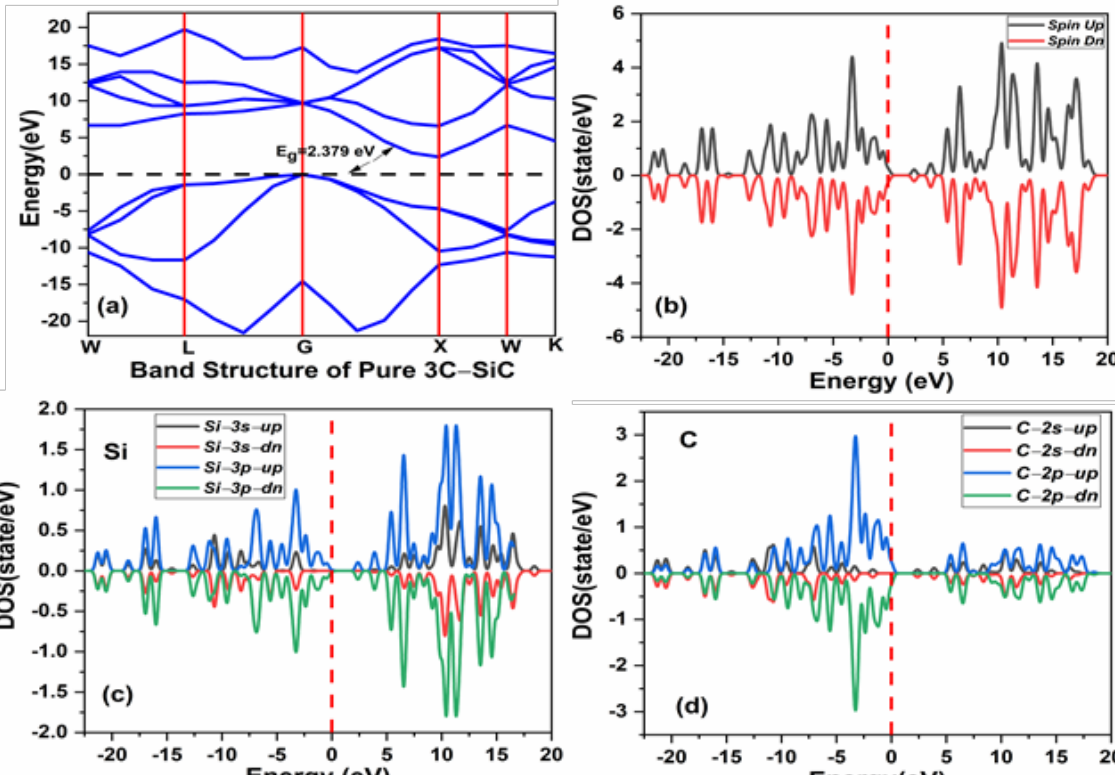
Figure 3. ( a ) The band structure of pristine 3C-SiC ( b ) spin polarized total density of states (TDOS) of pristine 3C-SiC, ( c ) partial density of state (PDOS) of Si, ( d ) and (PDOS) of C. Fermi level denoted by a black and red dash line.